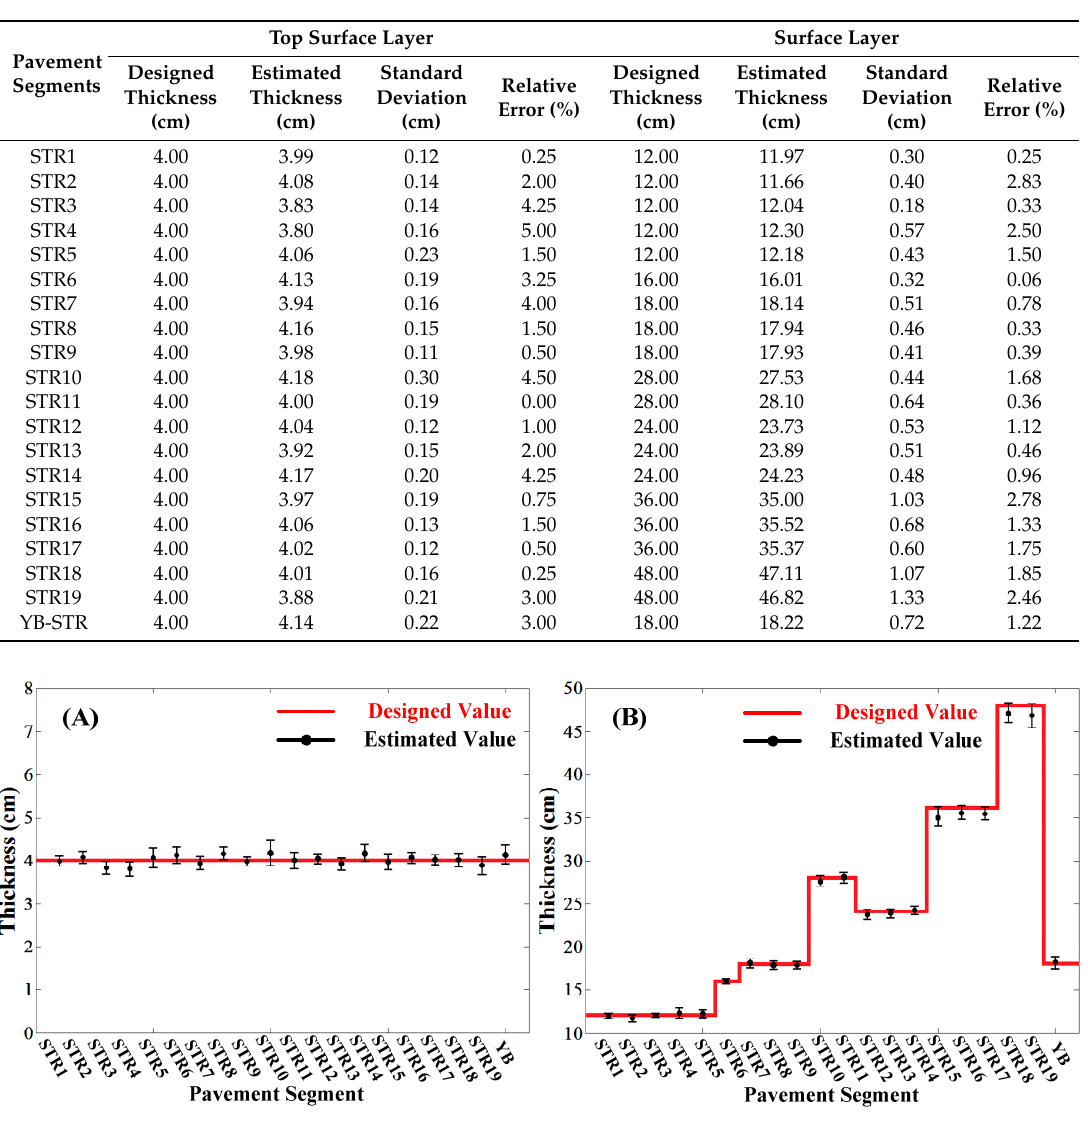
Figure 16. The comparison of designed thicknesses and estimated thicknesses of each pavement segments. ( A ) The top surface layer; ( B ) The surface layer.